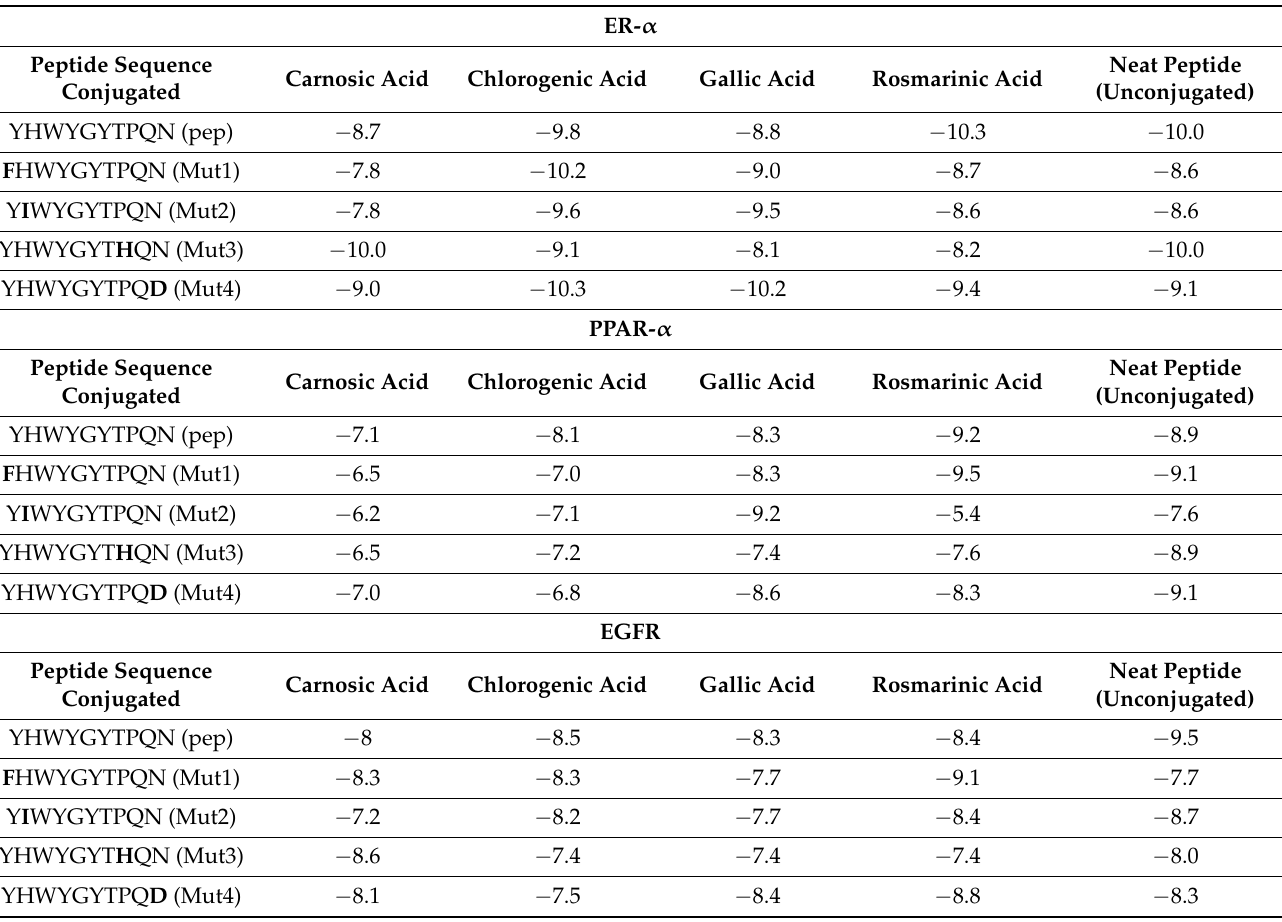
Table 4. Binding Affinities (kcal/mol) of Peptide, mutants and Peptide-Polyphenol Conjugates for ER- α ; PPAR- α , and EGFR using Autodock